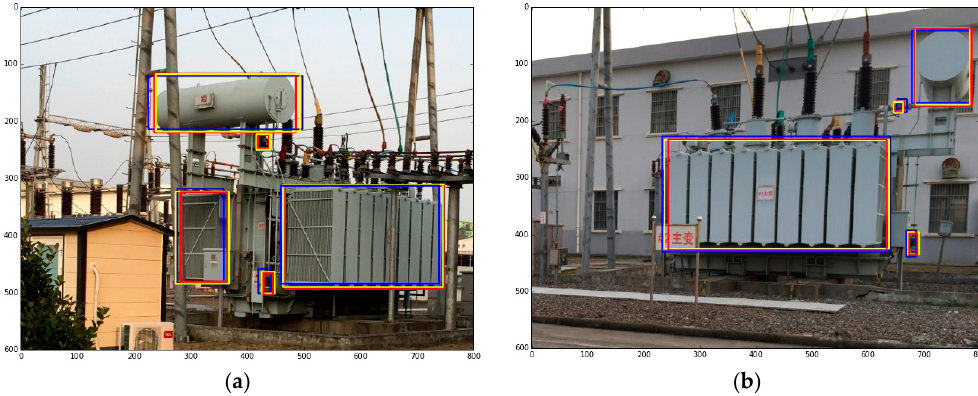
Figure 7. Detection results of two test images. The categories and probabilities are not displayed for brevity. ( a ) A relatively frontal shooting angle; ( b ) A lateral shooting angle.